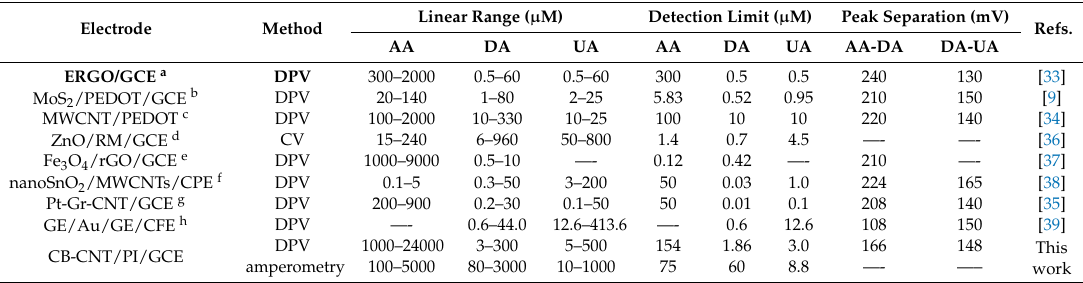
Table 3. Comparison of analytical performances the carbon black-carbon nanotube (CB-CNT)/polyimide (PI)/glassy carbon electrode (GCE) with other reported materials for electrochemical determination of AA, DA, and UA. Linear Range ( µ Electrode Method